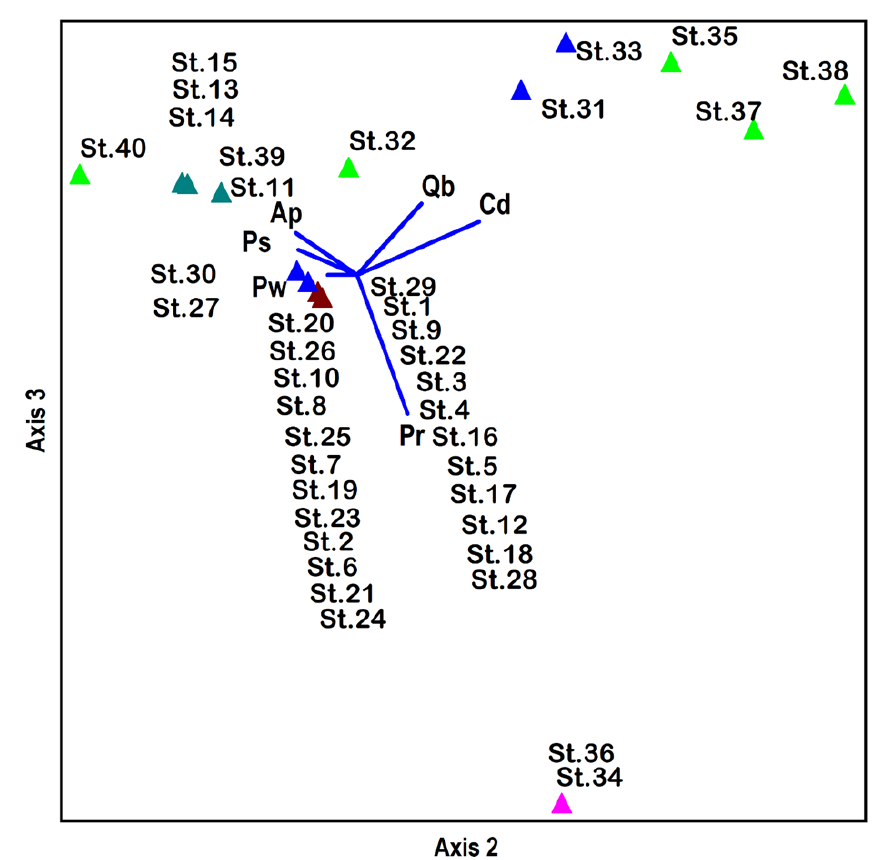
Figure 3. PCA stand ordination based on IVI of tree species from the Shangla district, Pakistan. The floristic composition/group obtained from Ward’s cluster analysis were super imposed on ordination axes. The different colors in the above ordination plan indicate different groups. (St indicates different stands in groups of vegetation.)